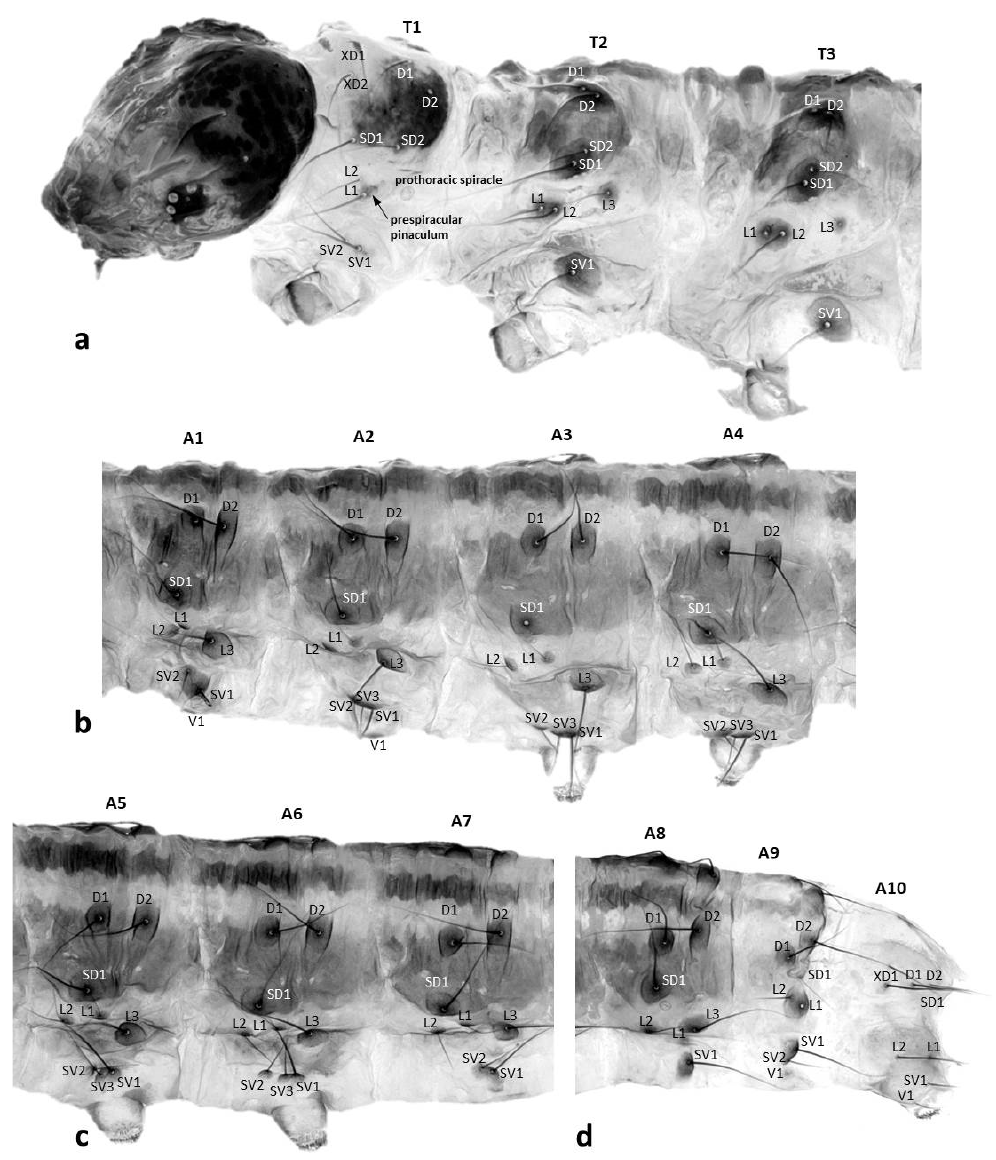
Figure 3. Chaetotaxy in larva of Yponomeuta meguronis : ( a ) T1–T3; ( b ) A1–A4; ( c ) A5–A7; ( d ) A8–A10. Abbreviation: D, dorsal setae; L, lateral setae; SD, subdorsal setae; SV, subventral setae; T1, prothorax, T2, mesothorax, T3, metathorax, A, abdominal segment. • Pupa (Figure 4); Adecticous, obtect; cylindrical, gradually narrowed posteriorly; cuticle light brownish yellow. Caput: Eyes moderate. Epicarania suture absent. Vertex subrectangular, wide laterally. Lateral invagination anterior to antenna. Antenna curved to medial body, extending to A5, before ending of metathoracic legs. Frontoclypeus rather ovate, paraclypeus narrowed rectangular. Tentorial fovea traversed mesially gena and eye. Labrum rather circular and posterior of frontoclypeus, bearing two postero-lateral projections, pilifers. Labial palpi posterior of labrum, between maxillae, longer than one third of the length of maxillae. Maxillae extending to A3. Mandibles small, posterior of gena and eye. Maxillae palpi, triangular sclerite, posterior of eyes, anterior of pro- and mesothoracic legs.